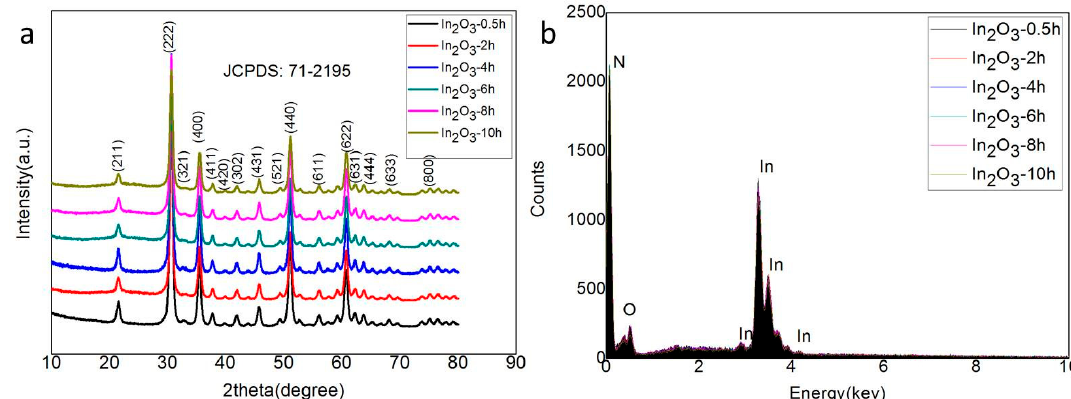
Figure 2. ( a ) X-ray diffraction (XRD) pattern of the samples; ( b ) Energy dispersive (EDS) spectrum analysis of the samples.